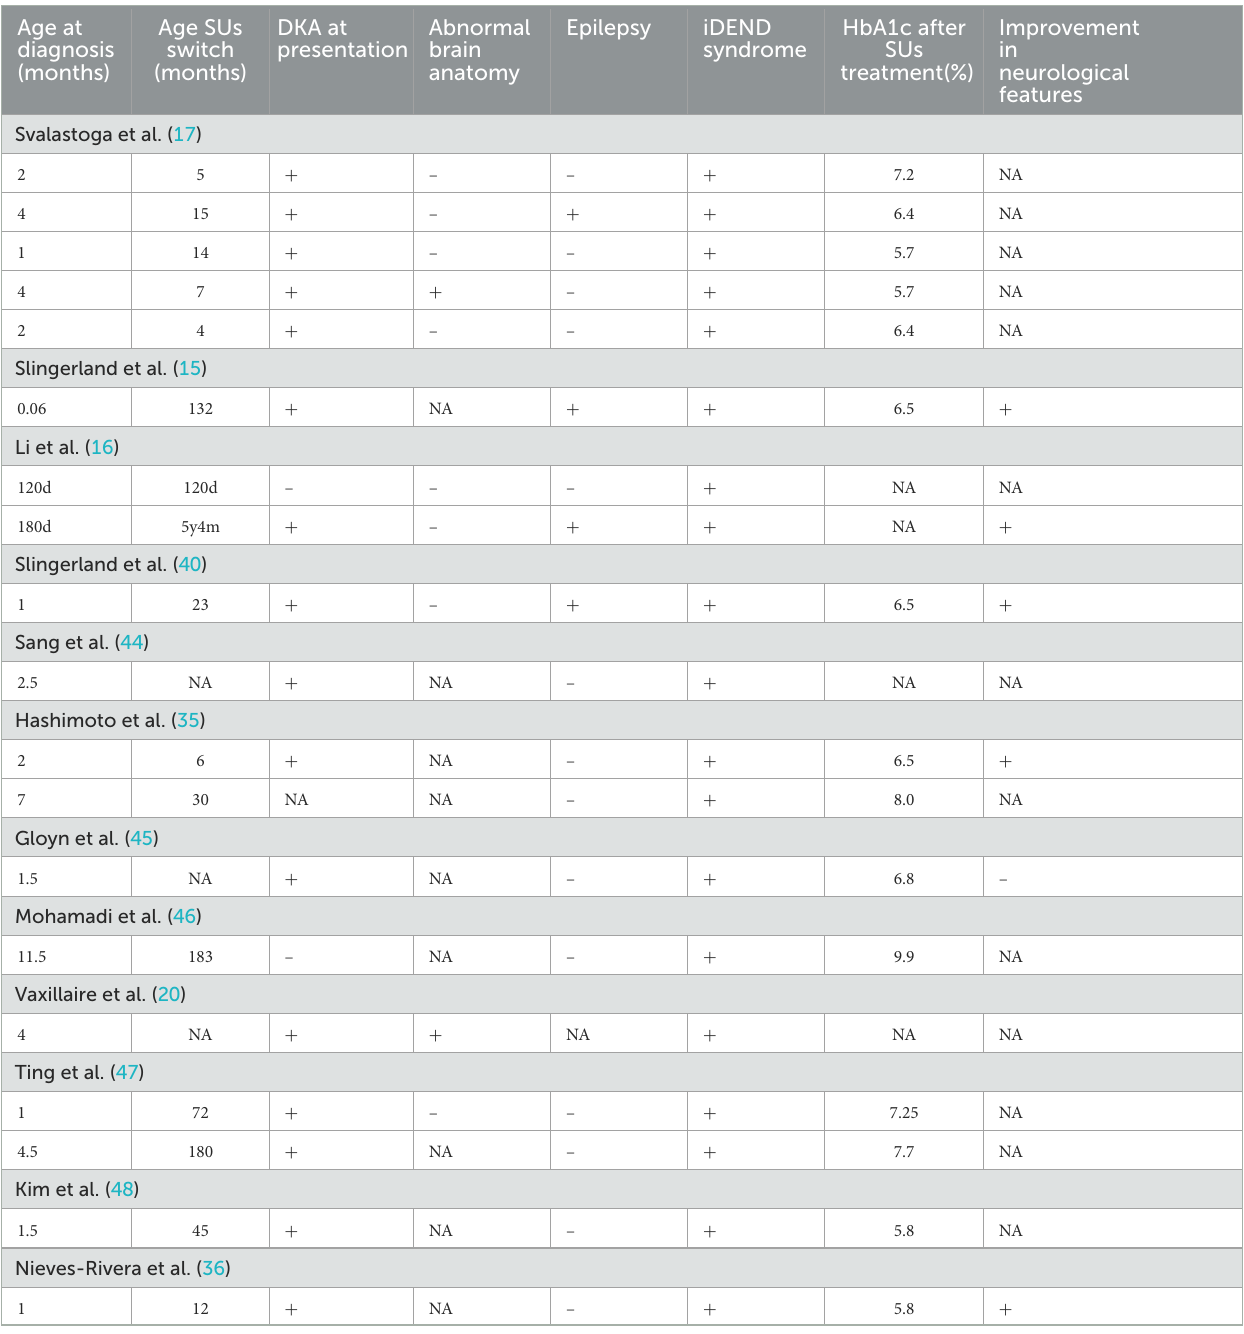
TABLE 1 Clinical data of patients with heterozygous p.V59M mutation. Age at